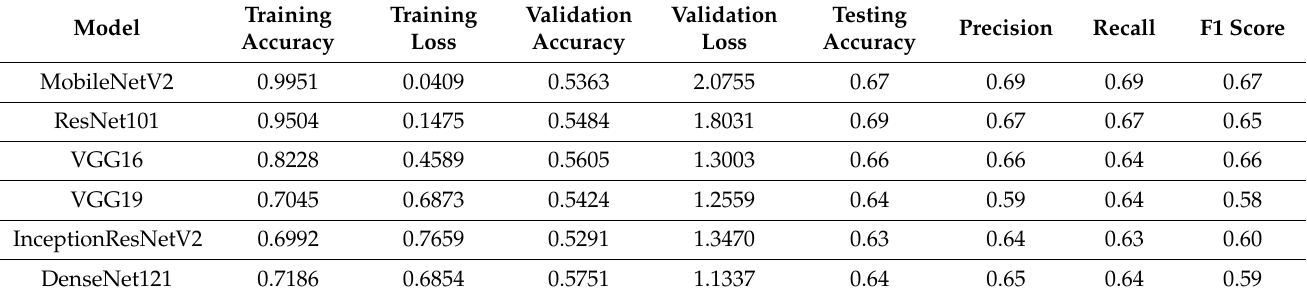
Table 3. Results of different classifiers on Dataset I containing 5 classes.